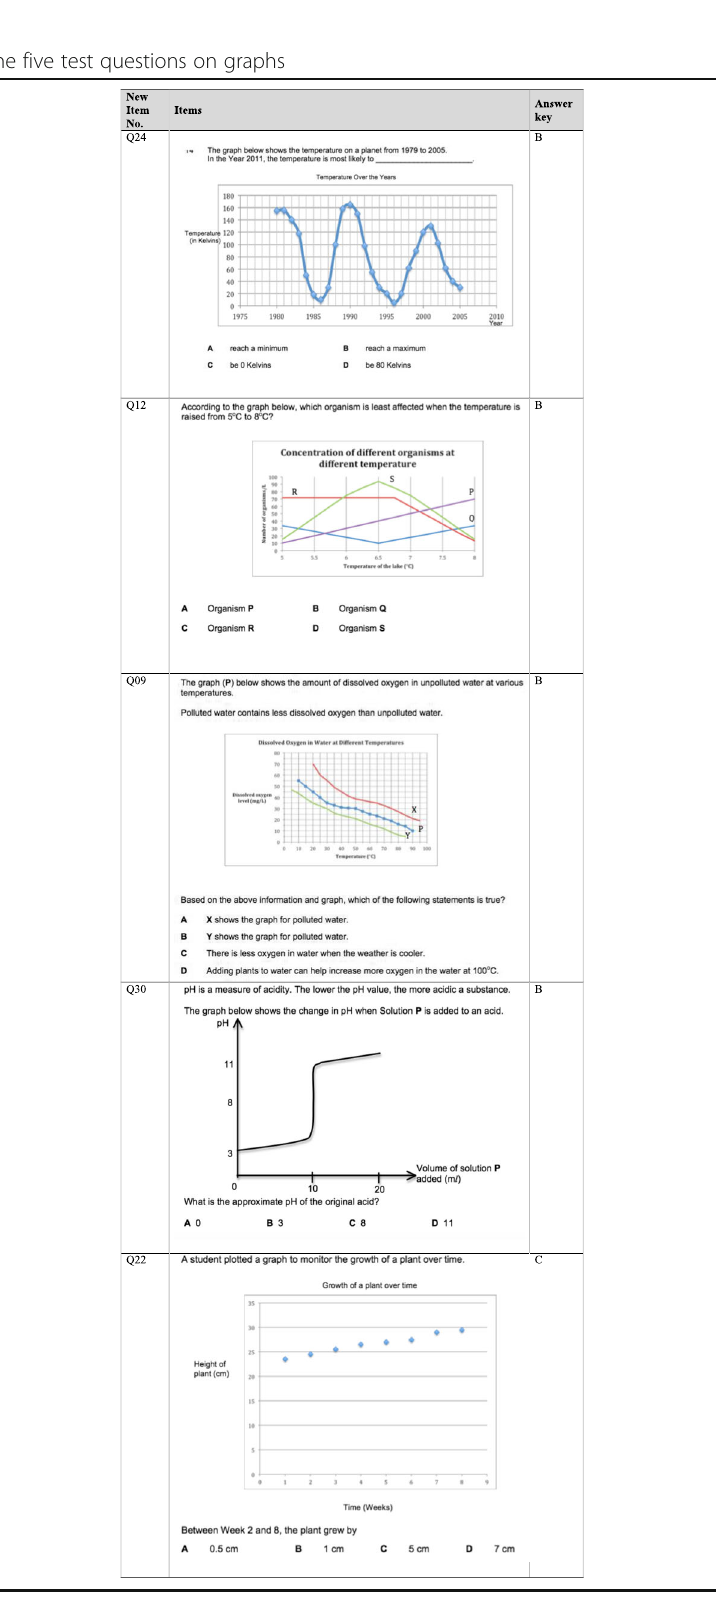
Table 4 The five test questions on